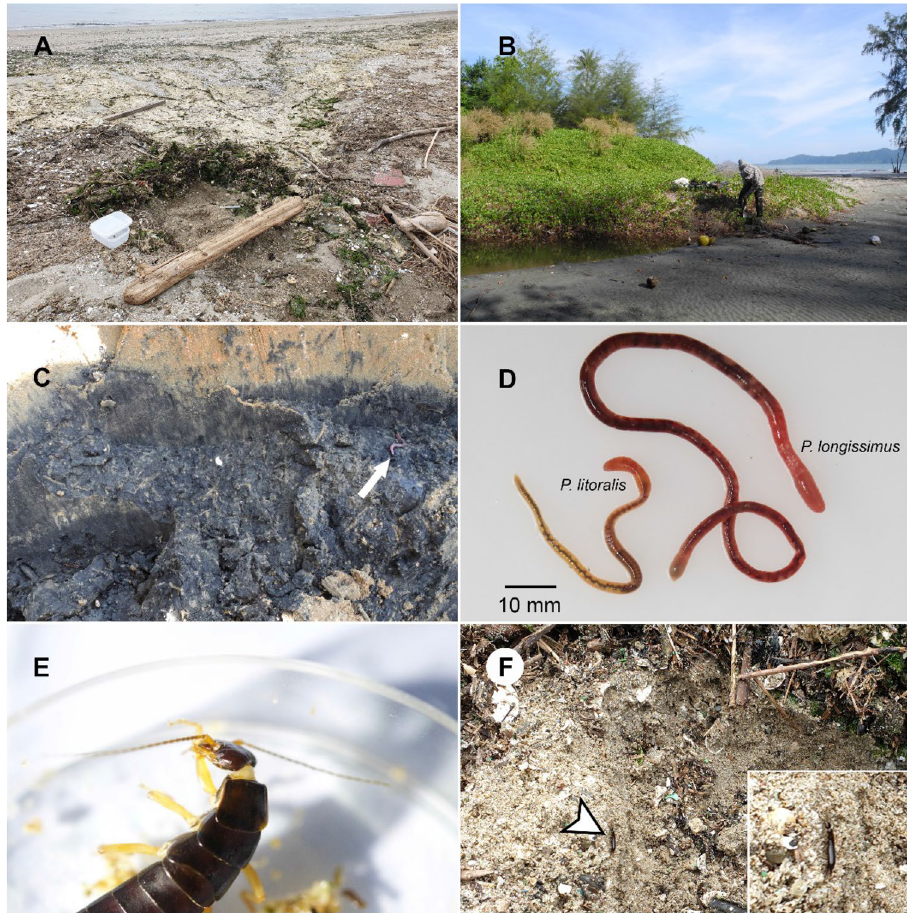
Figure 4. ( A ) The microhabitat of Pontodrilus litoralis from Aichi Prefecture, Japan. ( B ) The microhabitat of P. longissimus in Ranong, Thailand; sympatric Pontodrilus specimens were collected from this location 8 . ( C ) P. longissimus was found at a depth of 10–30 cm in muddy sand; the earthworm is shown by an arrow. ( D ) Bright field image of the Pontodrilus species included in this study. ( E ) An earwig ( Anisolabis maritima ) (a potential Pontodrilus predator) grooming its forelegs after attacking P. litoralis . ( F ) A. maritima (arrowhead) was found in the same microhabitat as P. litoralis in Aichi Prefecture,